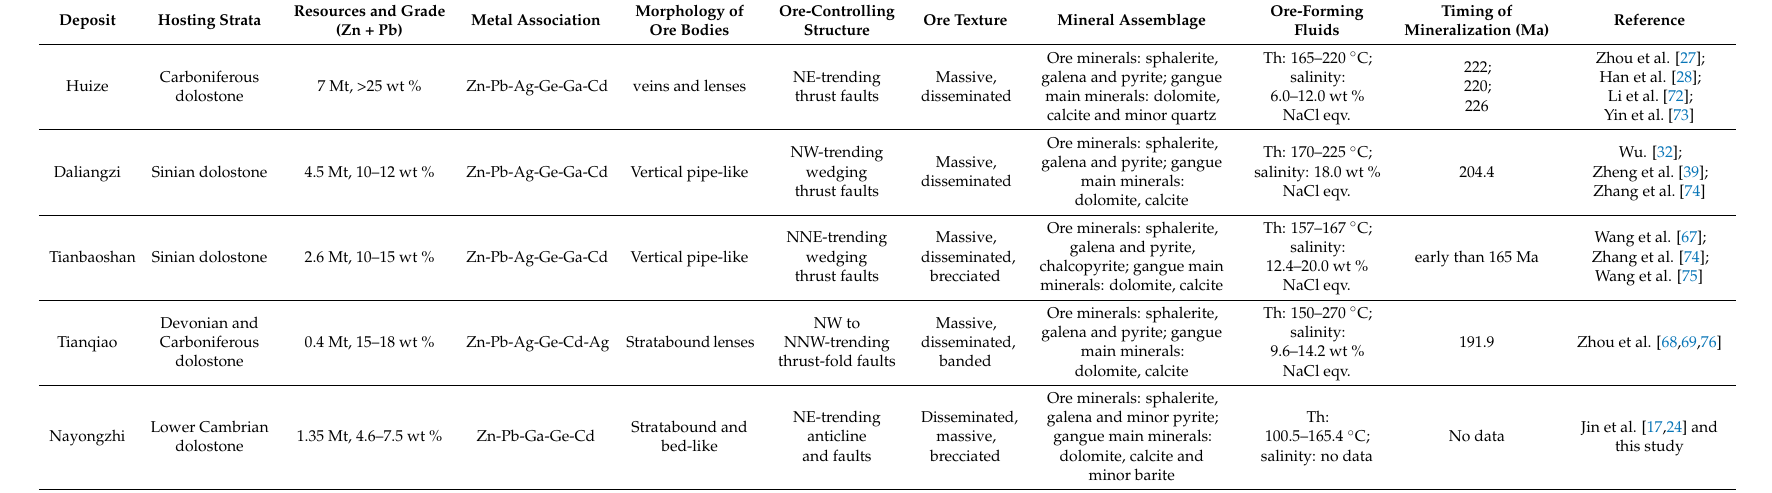
Table 3. Geological feature, ore-forming fluids and age of the typical MVT deposits in S-Y-G metallogenic